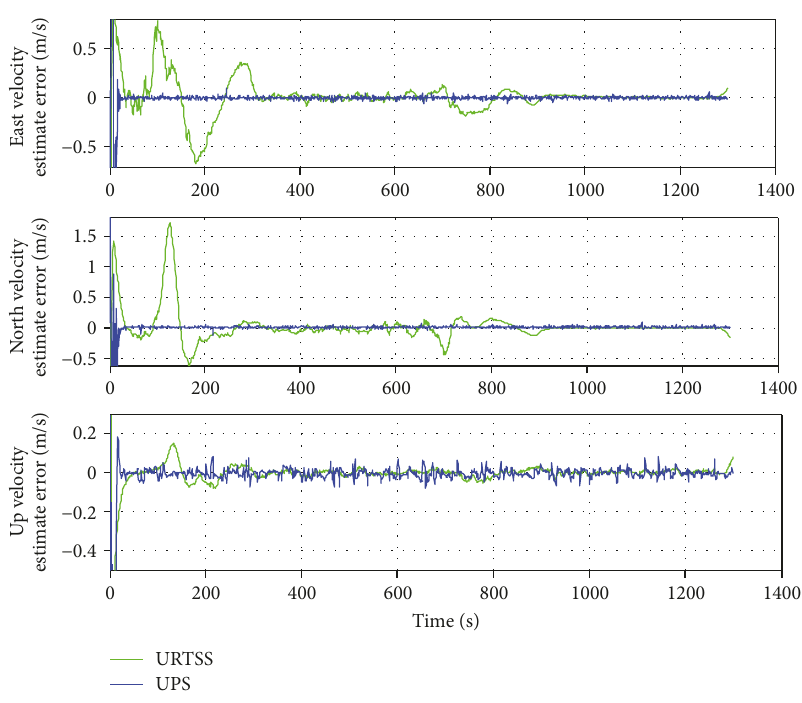
Figure 8: Velocity estimate errors of UPS and URTSS.